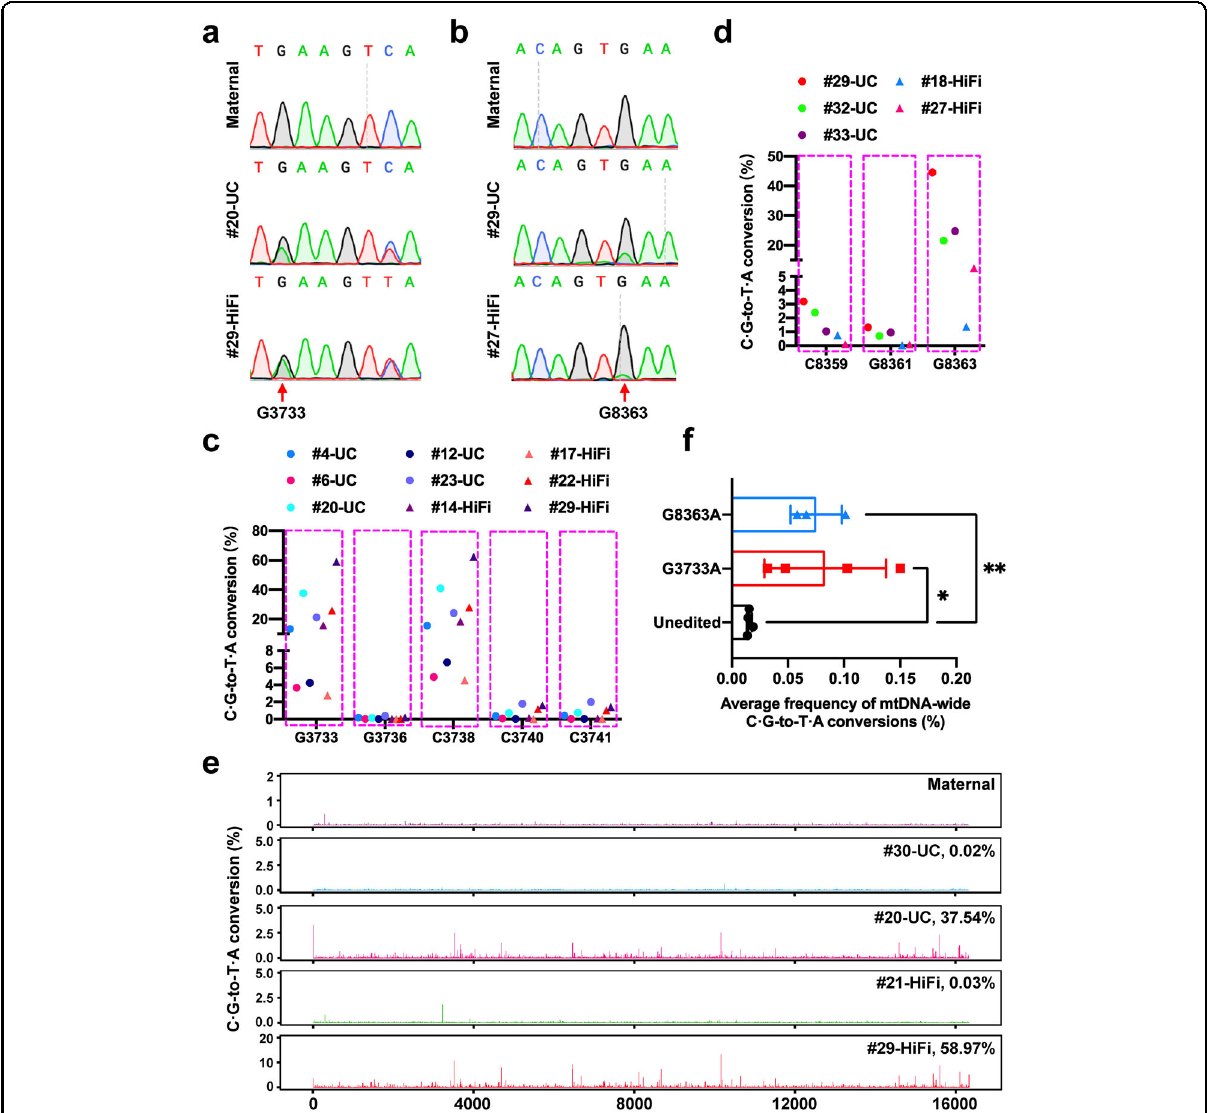
Fig. 1 DdCBE-mediated mtDNA base editing in human 3PN embryos. a Sequence chromatograms of maternal peripheral blood mononuclear cells (PBMCs) and 3PN embryos injected with G3733-DdCBE mRNAs. #20-UC and #29-HiFi embryos are derived from the same donor. The target site is indicated by the red arrow. b Sequence chromatograms of maternal PBMCs and 3PN embryos injected with G8363-DdCBE mRNAs. #29-UC and #27-HiFi embryos are derived from different donors. c , d Frequencies of C ∙ G-to-T ∙ A conversion within the spacing region of G3733A ( c ) and G8363A ( d ) embryos. Each dot represents an embryo. e Frequencies of off-target C ∙ G-to-T ∙ A conversions along the whole mtDNA of maternal PBMC and G3733A embryos. The frequency of on-target editing is labeled behind the embryo number. The four 3PN embryos are from the same donor. f Average frequency of mtDNA-wide C ∙ G-to-T ∙ A conversions for each DdCBE pair. Data are presented as means ± SD ( n = 4 for unedited controls and G3733A embryos, n = 3 for G8363A embryos). Signi fi cance was calculated with unpaired two-tailed Student ’ s t -test ( * P < 0.05, ** P <